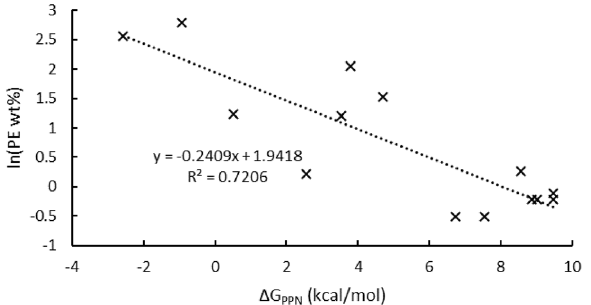
Figure 7. Reported polyethylene by-product production versus ΔG PPN in graphical